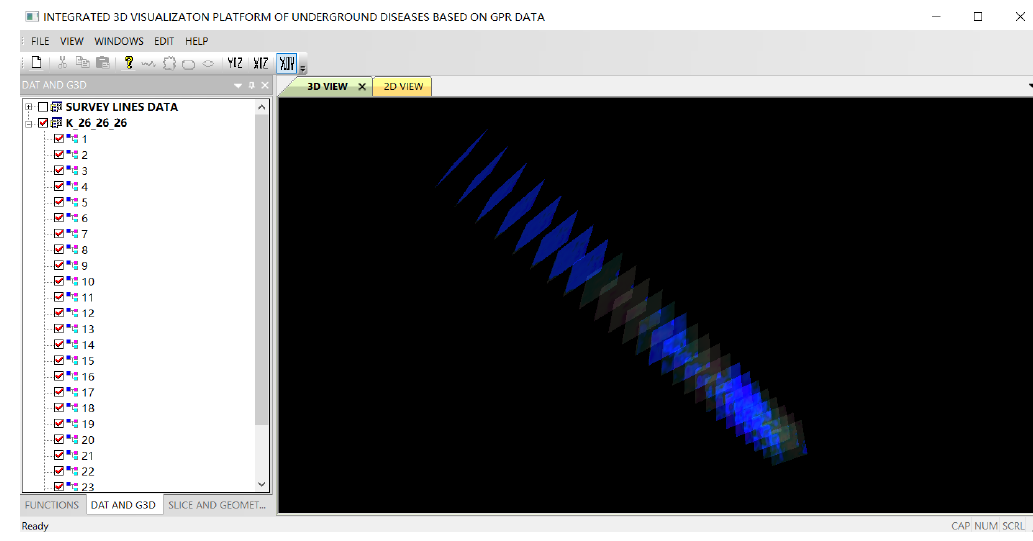
Figure 10. G3D data visualization.